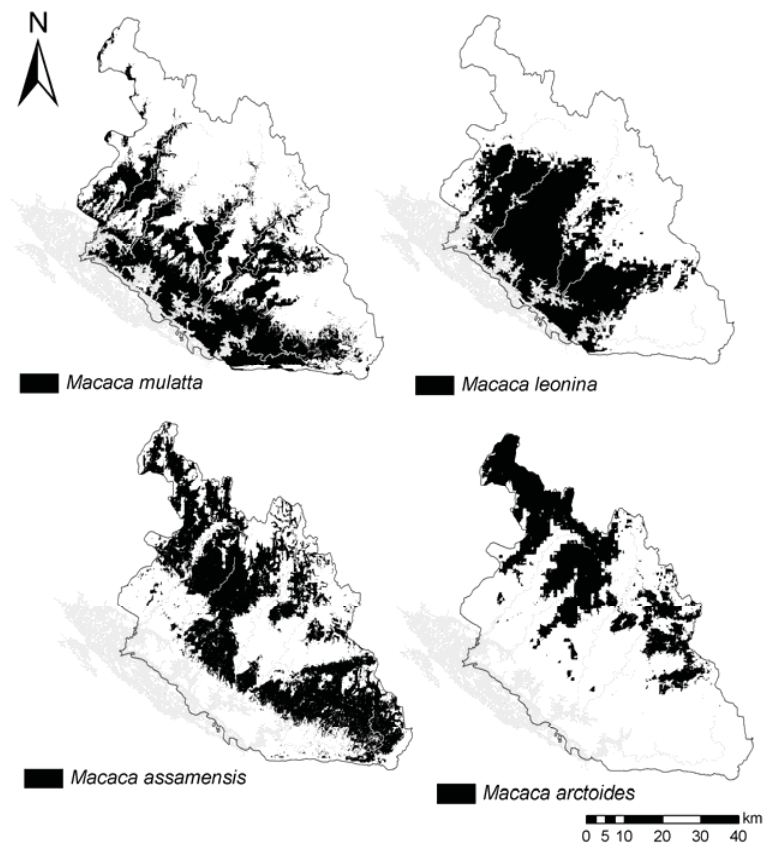
Figure 2. Respective predicted distribution of the four species of macaques occurring in Nakai-Nam Theun National Protected Area (NNT NPA) (predicted distribution size: 1,289 km 2 ).